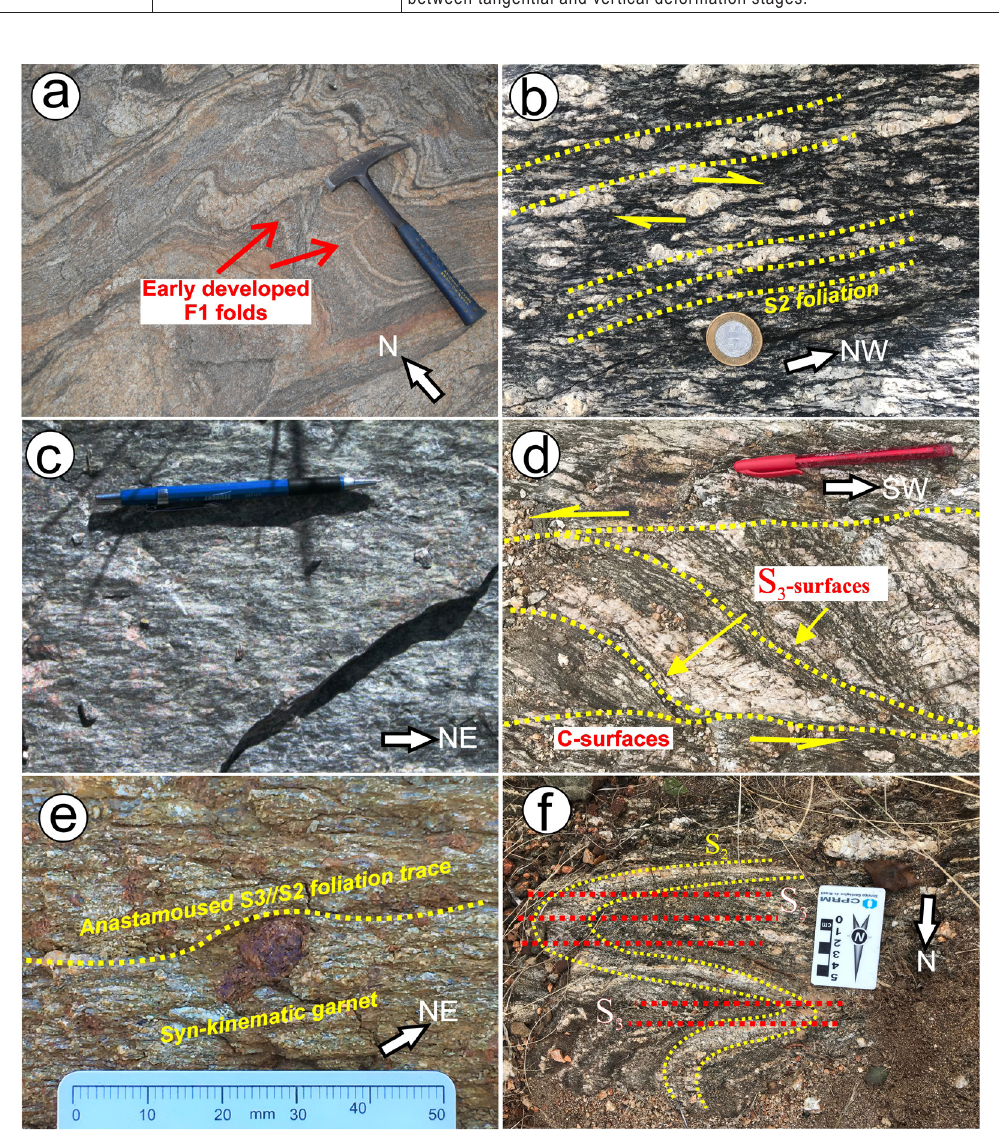
FIGURE 3 - Mesoscopic aspects of the studied area: a) Folded migmatite showing evidence of early deformation in the studied area; b) deformed porphyroclast along the S foliation, suggesting top-to-the-NW tectonic vergence during thrusting event; c) horizontal to sub-horizontal mineral 2 stretching lineation recorded in intrusive mylonitic orthogneiss (L ); d) S-C structures as well as a deformed quartz-feldspar aggregate suggesting 3 sinistral movement related to the Congo-Cruzeiro do Nordeste Shear Zone, cropping out in metasedimentary rocks of the Sertânia Complex; e) syn-kinematic garnets deformed along vertical foliation planes related to strike-slip tectonics in garnet-biotite schist from the Sertânia Complex; f) folded S -related foliation by the later transcurrent D deformation resulting in the development of close to isoclinal syn-kinematic folds. 2 3